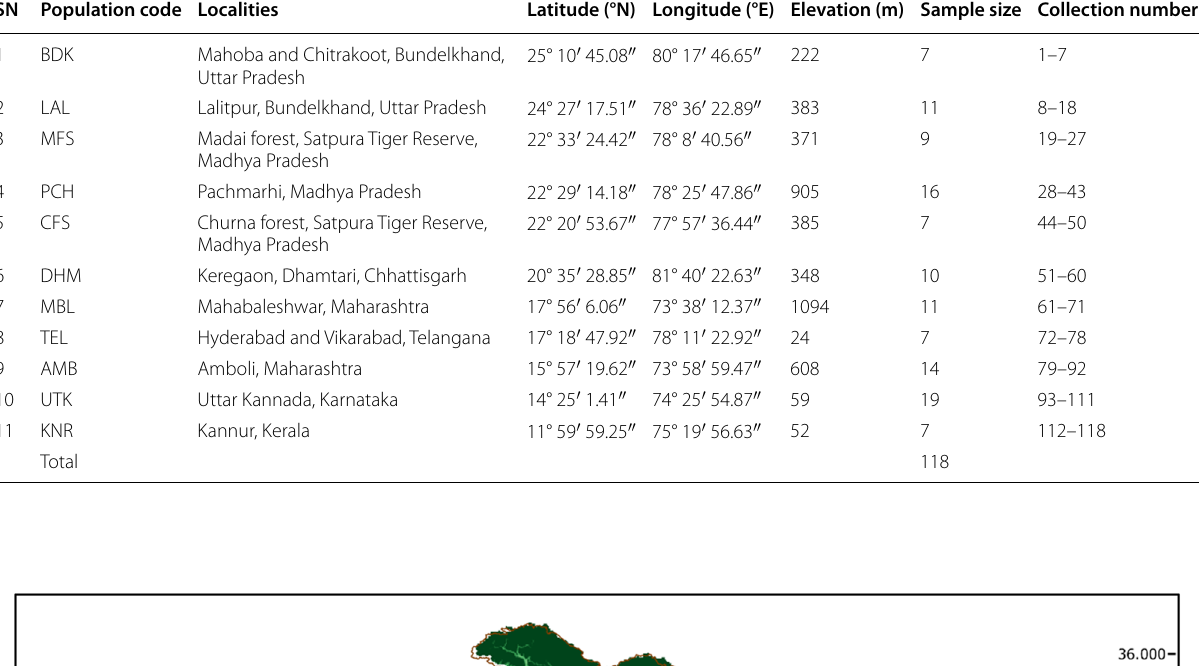
Table 1 Details of wild populations of G. sylvestre collected from different locations of India SN Population code Localities